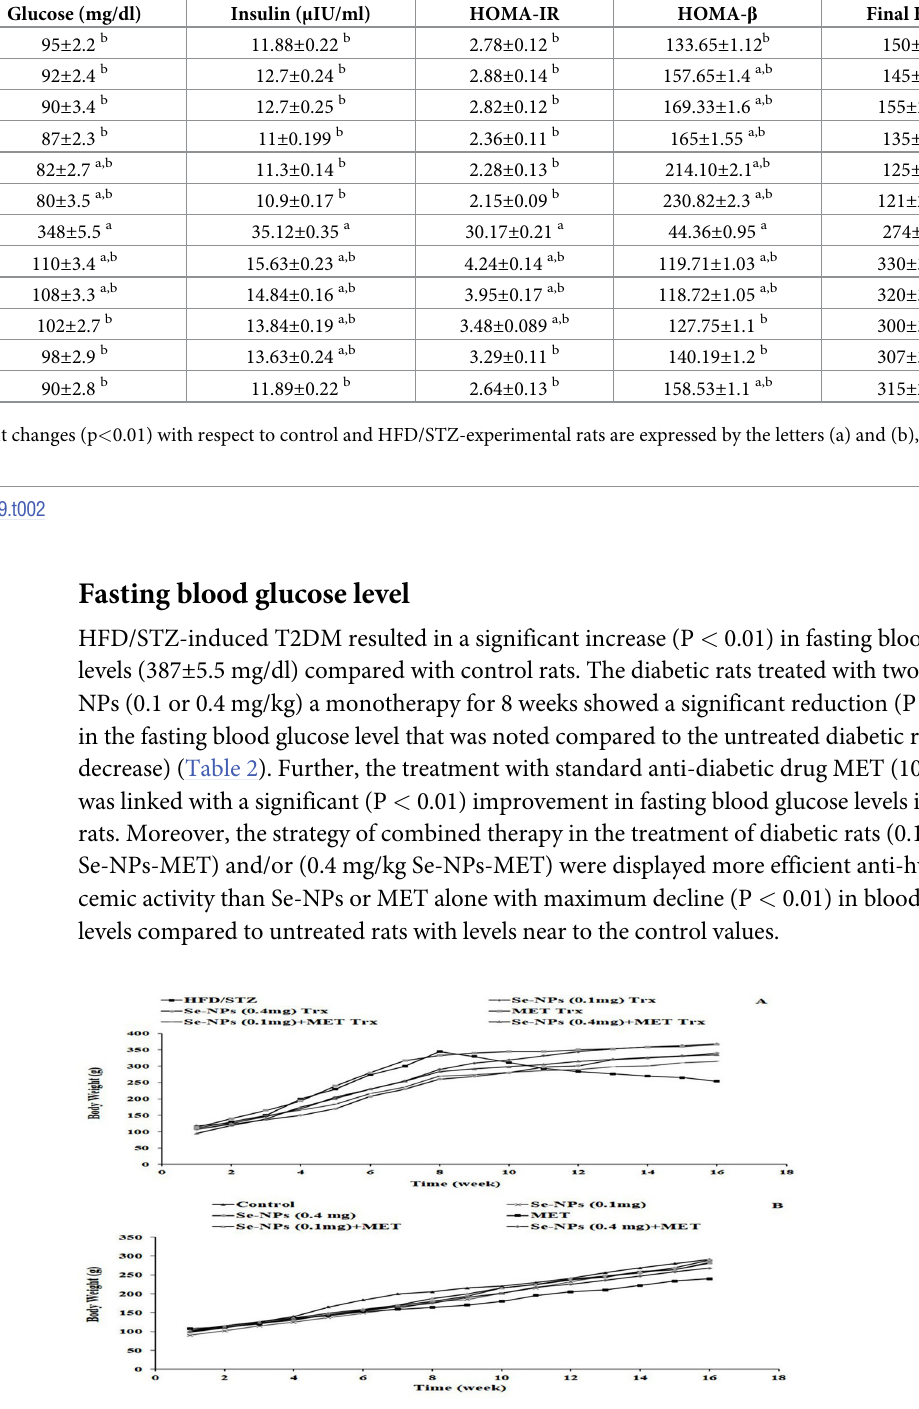
Table 2. Effect of two doses of Se-NPs, MET monotherapy, and combined therapy on the blood glucose levels, serum insulin levels, HOMA-IR, HOMA- β , and final body weight over 16 weeks in control and HFD/STZ-experimental rats. Groups